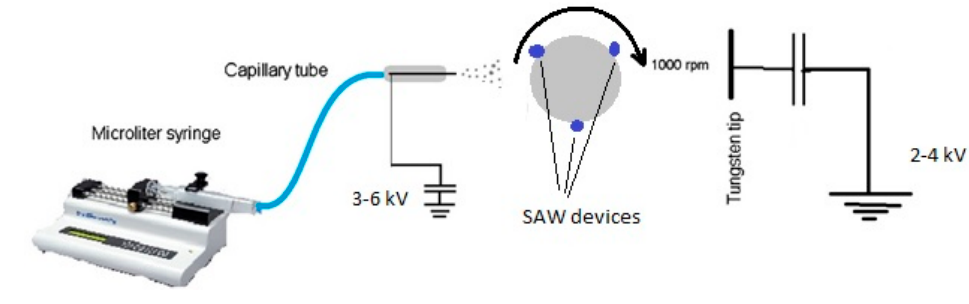
Figure 2. Schematic diagram of the electrospraying system.